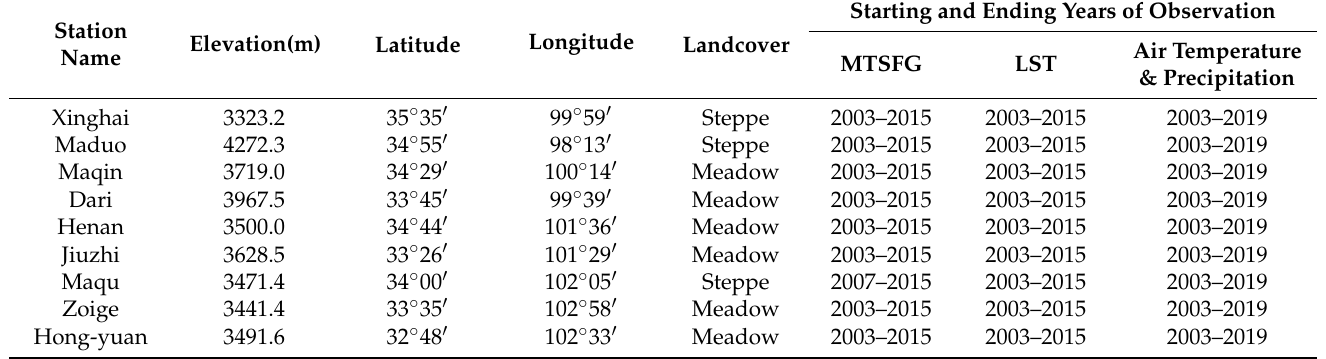
Table 1. Description of the observed data at nine national meteorological stations.